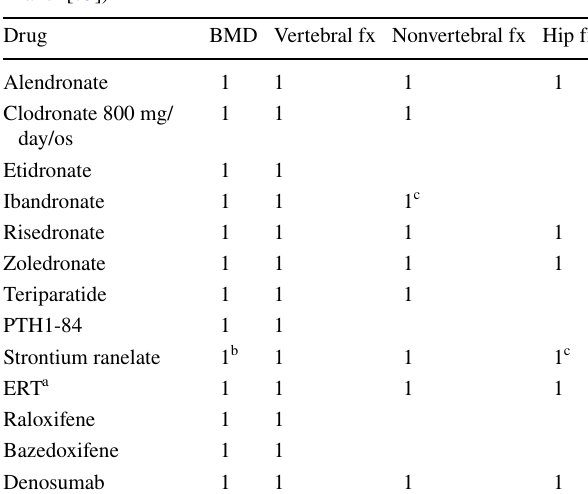
Table 5 Approved drugs for postmenopausal osteoporosis. Repro- duced (with permission) from Table 6 of the Guidance for the diag‑ nosis, prevention and therapy of osteoporosis in Italy (Cianferotti